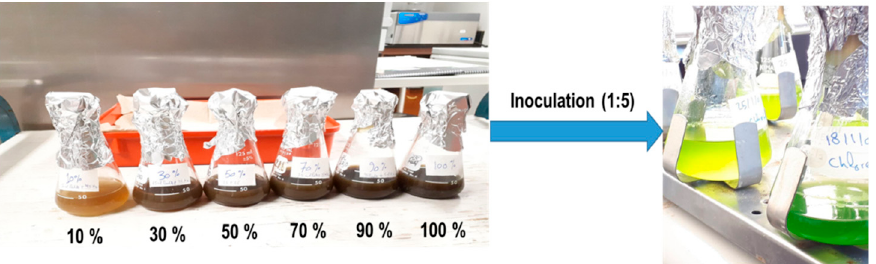
Figure 1. Various diluted samples of anaerobically digested CM (10 to 100%) used for microalgae cultivation experiments. cultivation